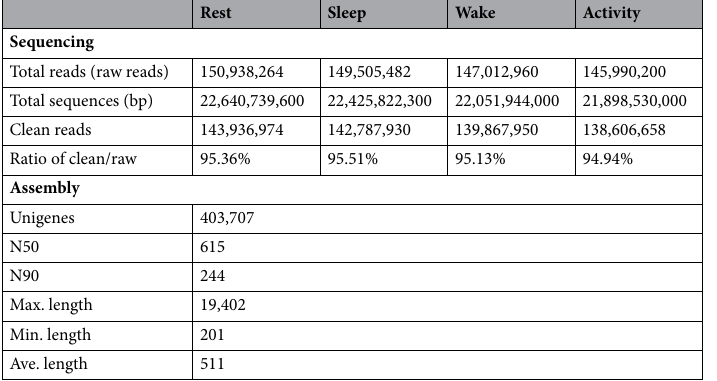
Table 1. Sequencing and assembly statistics of brain samples for V. sinensis.